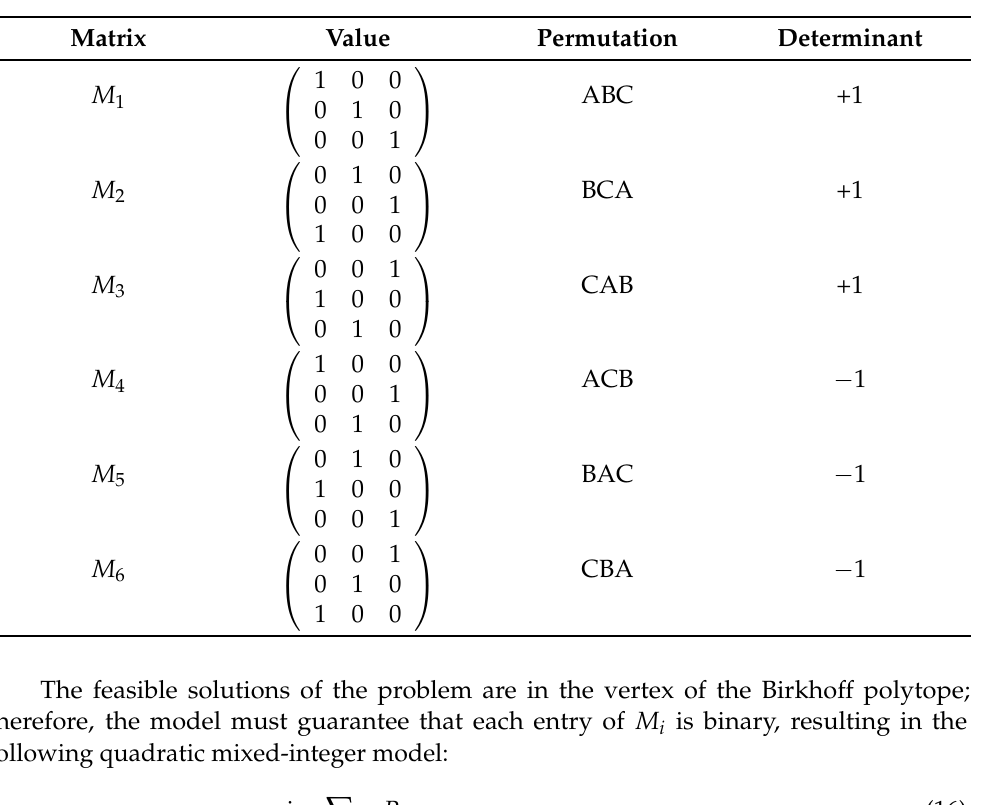
Figure 2. Schematic representation of the Birkhoff polytope B 3 . This is only a representation since the real politope belongs to the space R 3 × 3 . Table 1. Feasible permutations for the phase-balancing